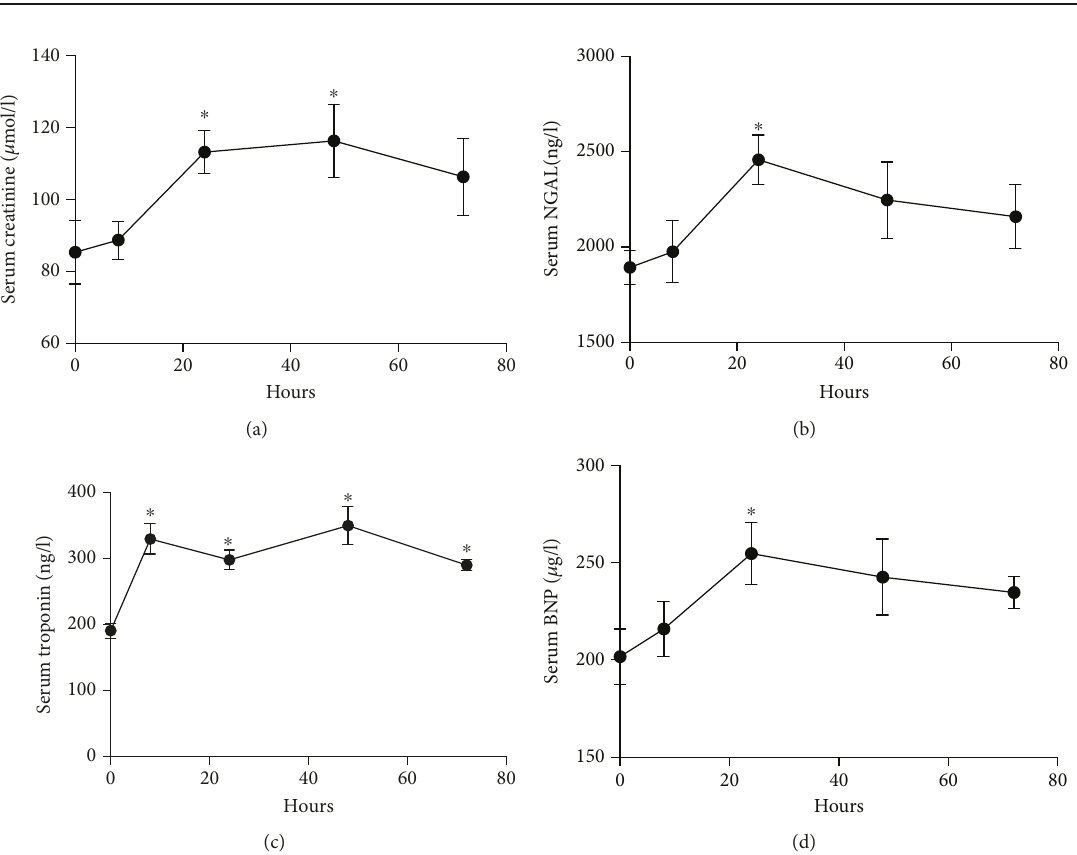
Figure 1: LPS-induced acute cardiac injury and acute kidney injury (a – d). Serum samples were collected from mice at 0 h, 6 h, 24 h, 48 h, and 72 h after. LPS (10 mg/kg) injection ( n = 6 ). Serum creatinine (a), NGAL (b), troponin (c), and BNP (d) levels were measured by ELISA. ∗ p < 0 05